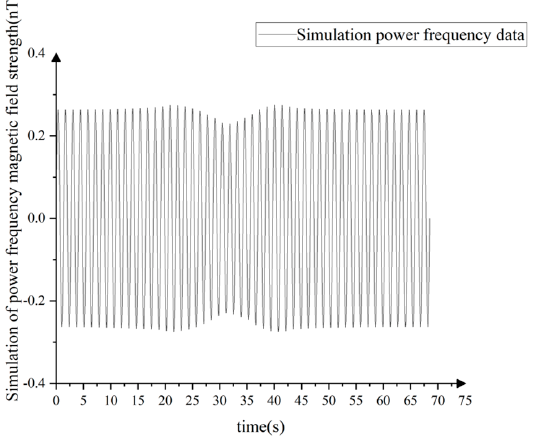
Figure 2. Simulates the time − domain magnetic perturbation